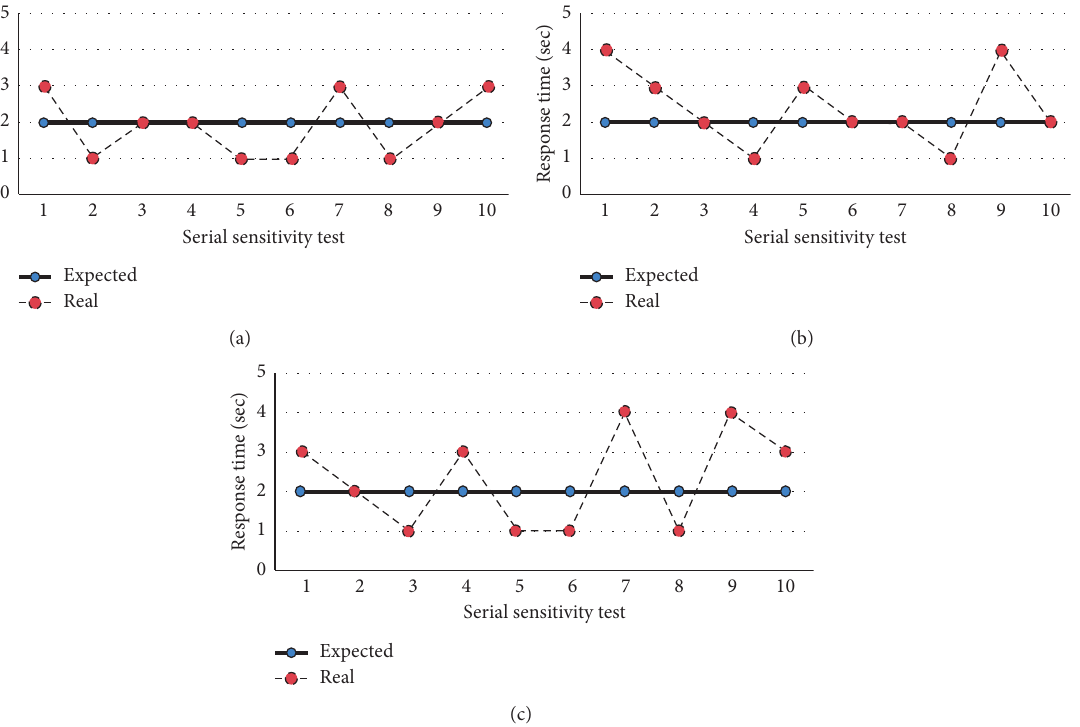
Figure 11: (a) Expected time of sensing for the fist mode, (b) expected time of sensing for the grip mode, and (c) expected time of sensing for the handshake mode.